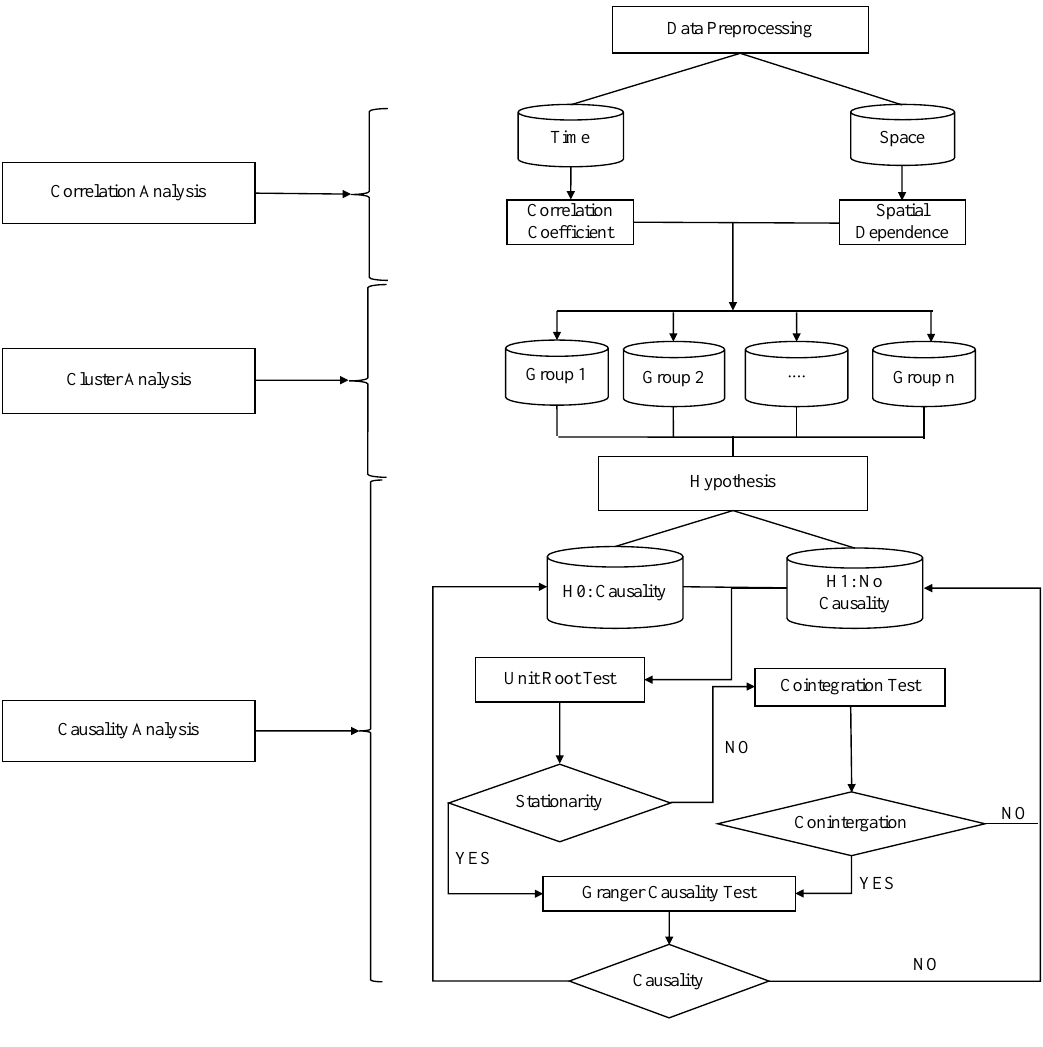
Figure 1. Analysis flow chart.